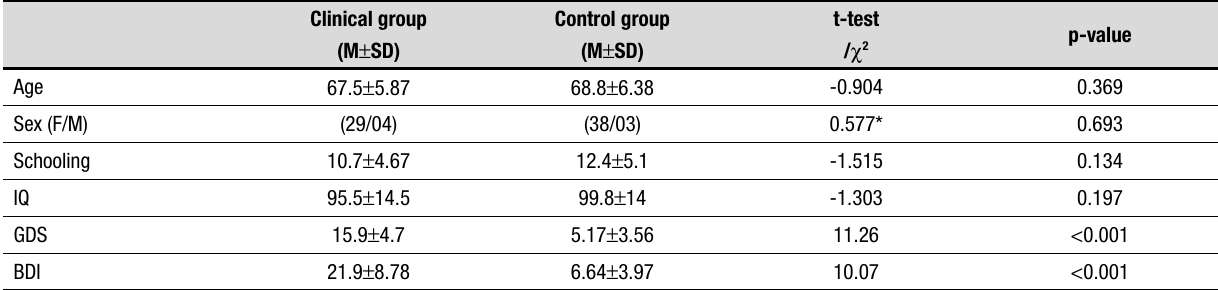
Table 1. Characteristics of the clinical group and the control